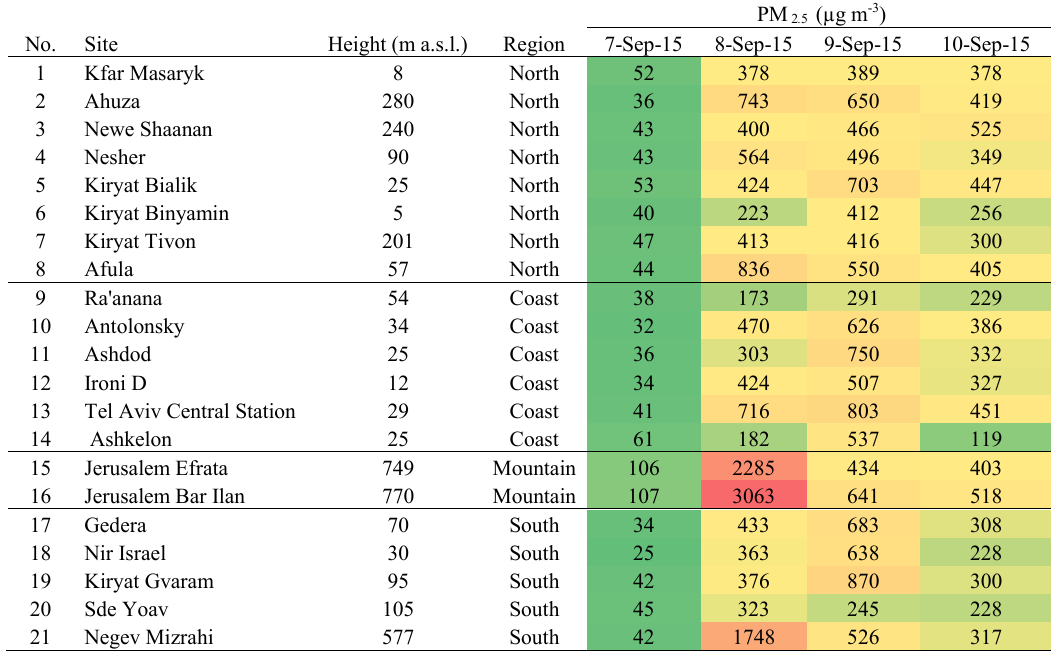
Table 5. Hourly maximum concentration of PM2.5, collected from 21 monitoring sites, between 7 and 10 September 2015. The values are ranked from low (dark green) to high (dark red) values.